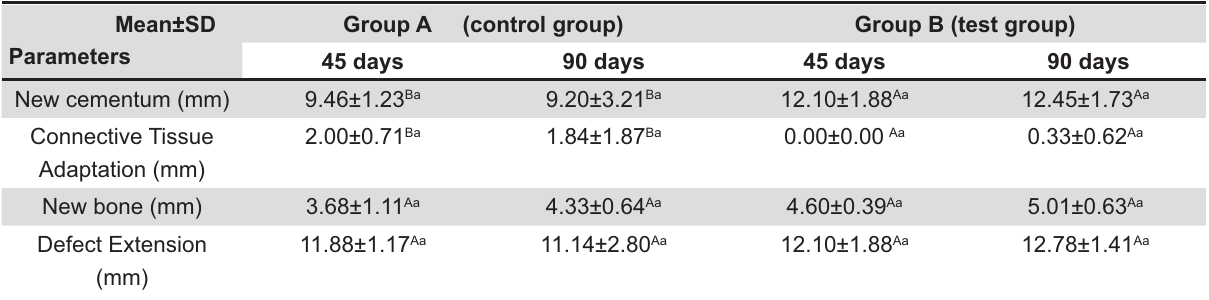
Capital letters compare treatments within each time and non-capital letter compare times within each treatment. Means followed by different letters are statistically